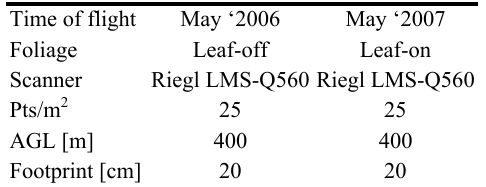
Table 3. Configurations for two airborne LiDAR campaigns